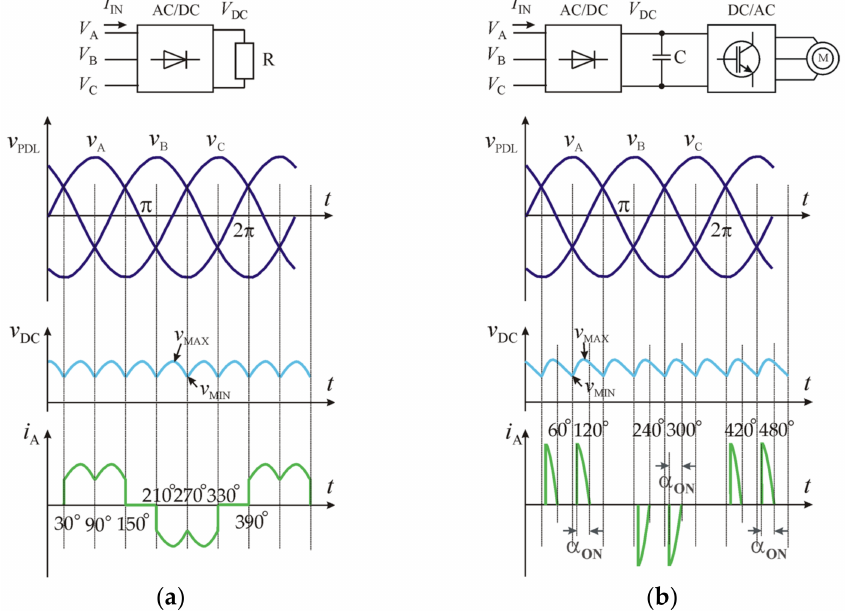
Figure 3. Time diagrams of the voltage and current of three-phase diode rectifier supply-side VFD: ( a ) pure resistor load; ( b ) conventional